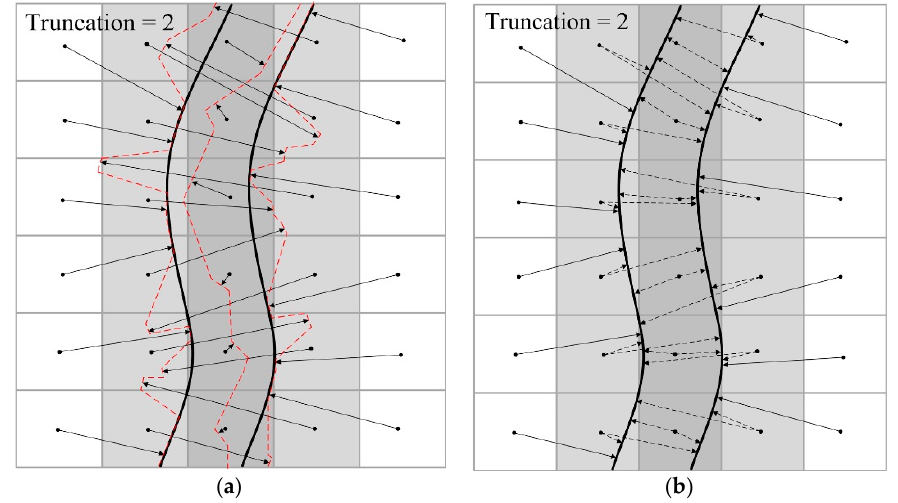
Figure 6. Corrupted thin surface vs. the correct thin surface; ( a ) interfered TSDF and corrupted surfaces; ( b ) correct TSDF.